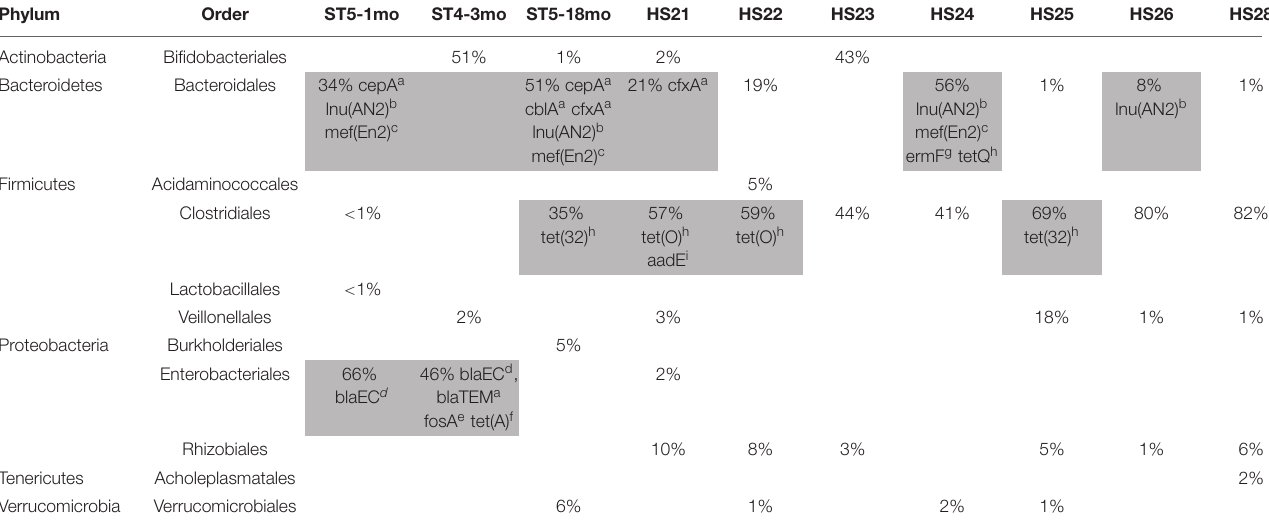
TABLE 2 | Percentages of major bacterial Orders in the fecal microbiota of human samples. Phylum Order ST5-1mo Actinobacteria Bifidobacteriales Bacteroidetes